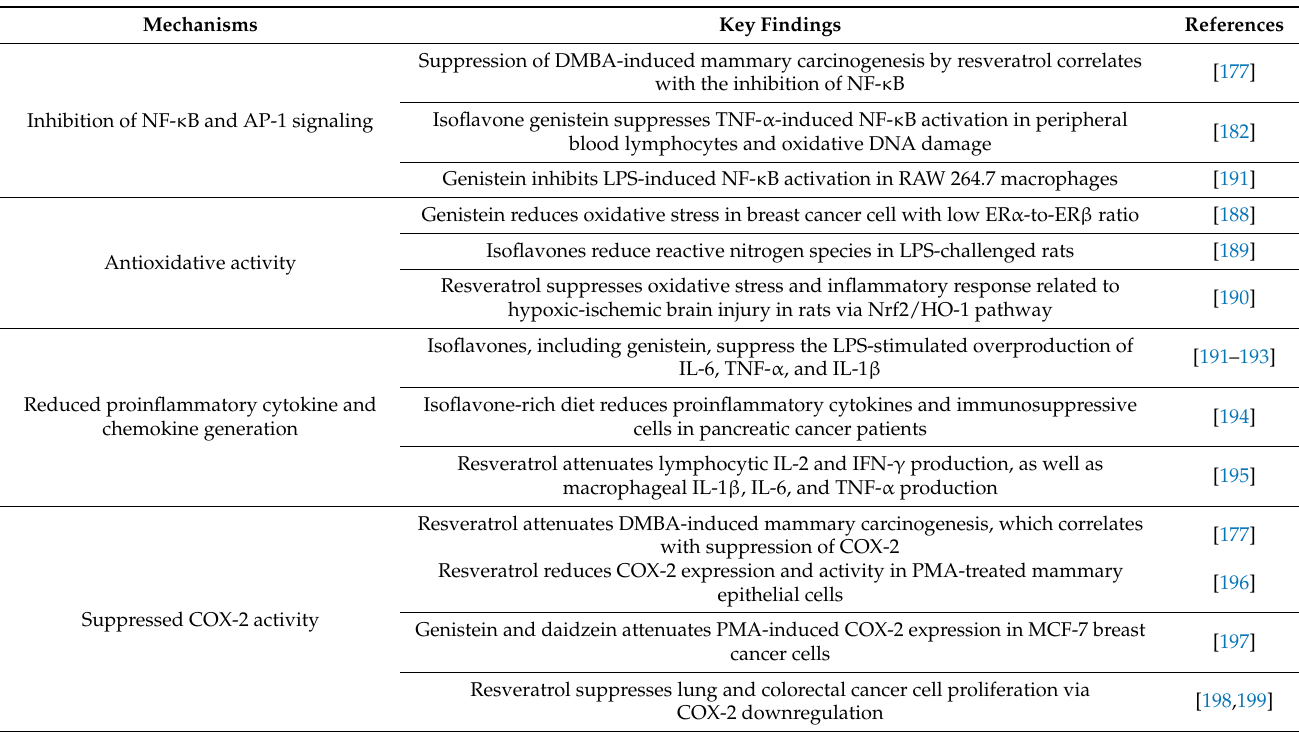
Table 2. Anti-inflammatory roles of